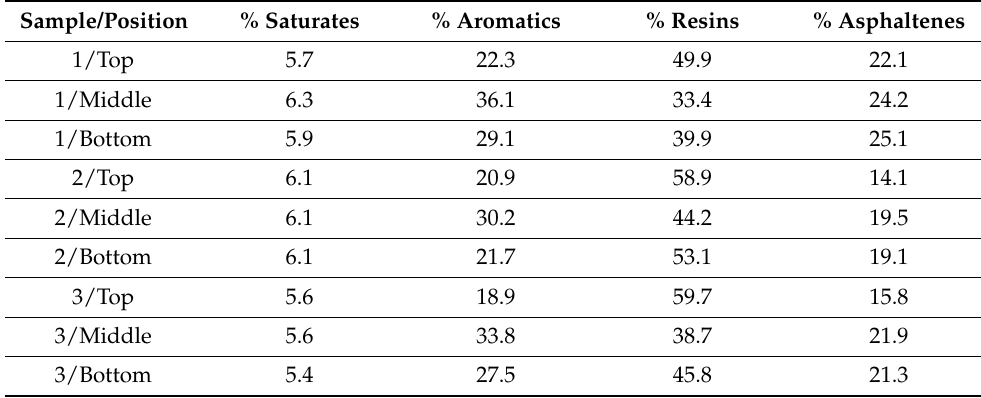
Table 7. Iatroscan SARA analysis results of UV aged